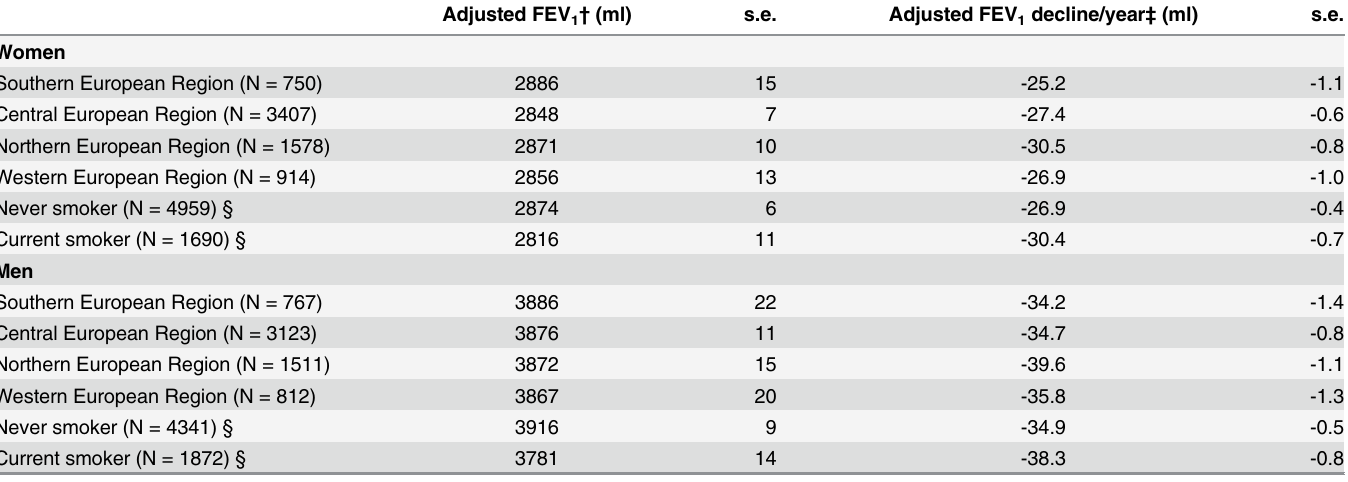
Table 2. Age and height adjusted FEV 1 and FEV 1 decline per follow-up year ( Δ FEV 1 /yr.) in women and men, by European region and by smoking status.